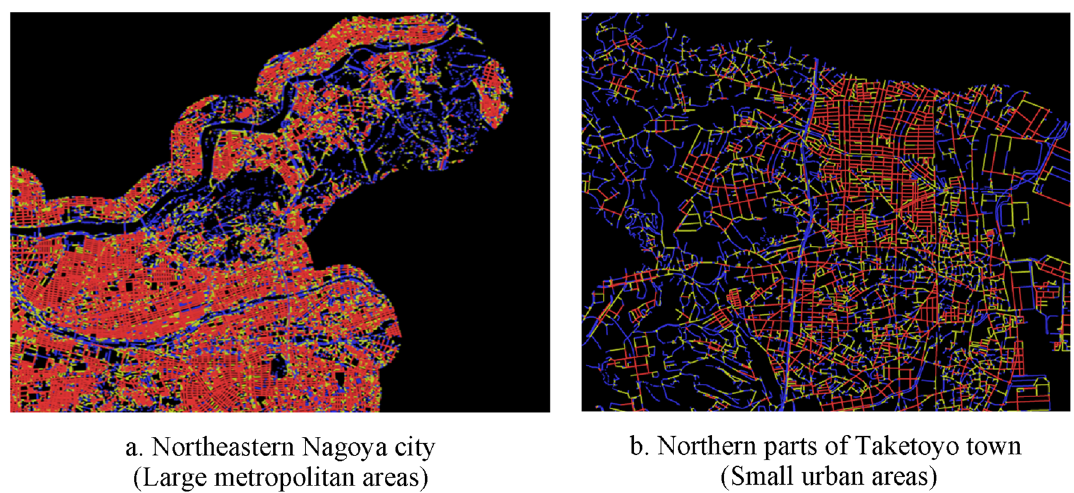
Figure 4. Space syntax connectivity maps of research municipalities. Panels ( a ) and ( b ) show areas of both low and high connectivity in both large metropolitan areas and small urban areas. High-population areas show higher street connectivity than low population